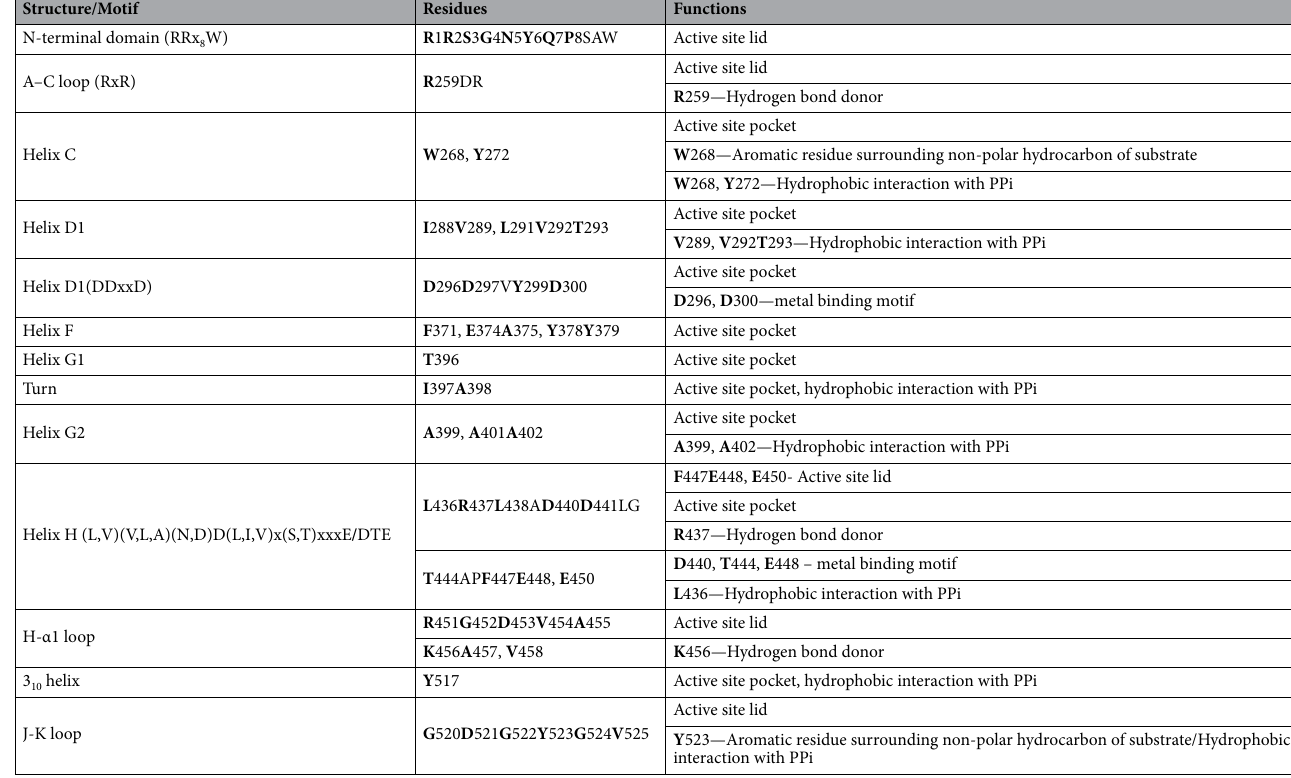
Table 3. Amino acid residues involved in the establishment of Pam Tps1 active site pocket and catalysis activity predicted using CASTp and